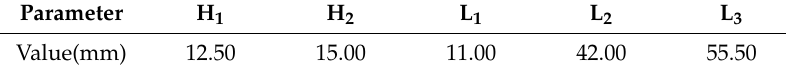
Table 10. Optimal parameter values.